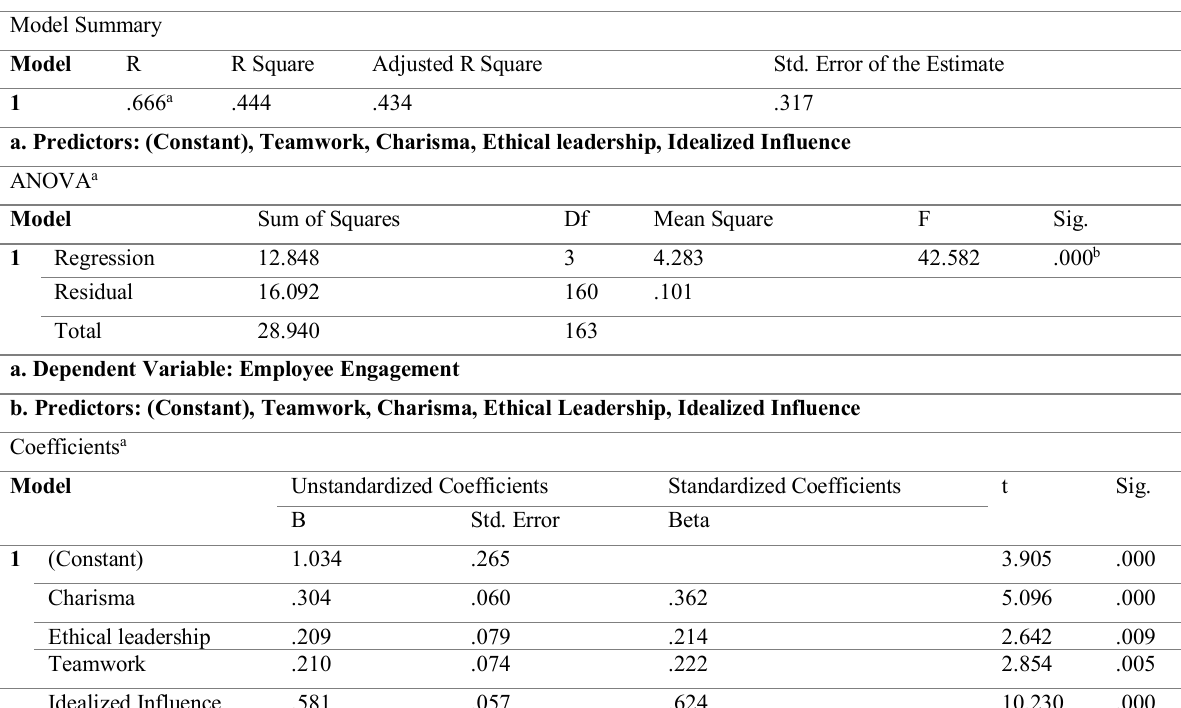
Table 2: Regression Analysis for Idealized Influence and Employee